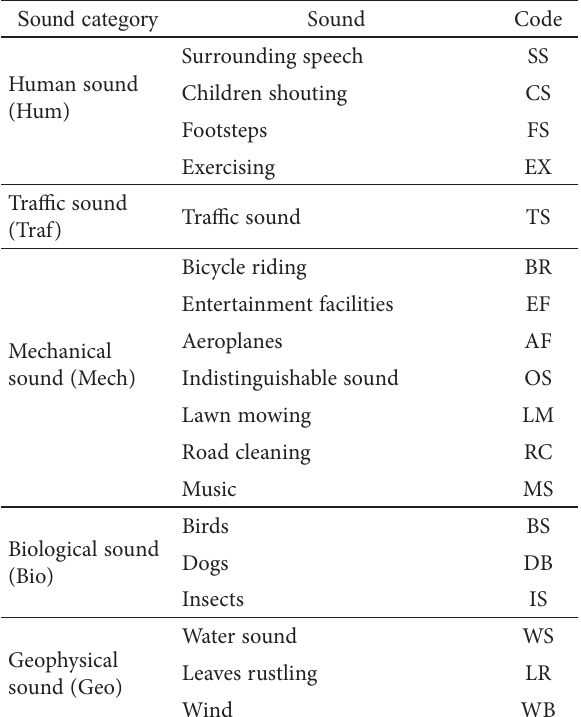
Table 1. Recognised sounds and their corresponding sound categories in the city